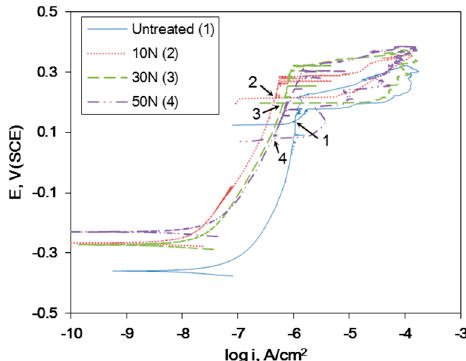
Figure 11. The effect of the static load in UNSM treatment on the polarization curve of Alloy 600 in deaerated 1% NaCl at 30 °C. Table 3. Corrosion factors obtained from Figure 10 by the static load in UNSM treatment.